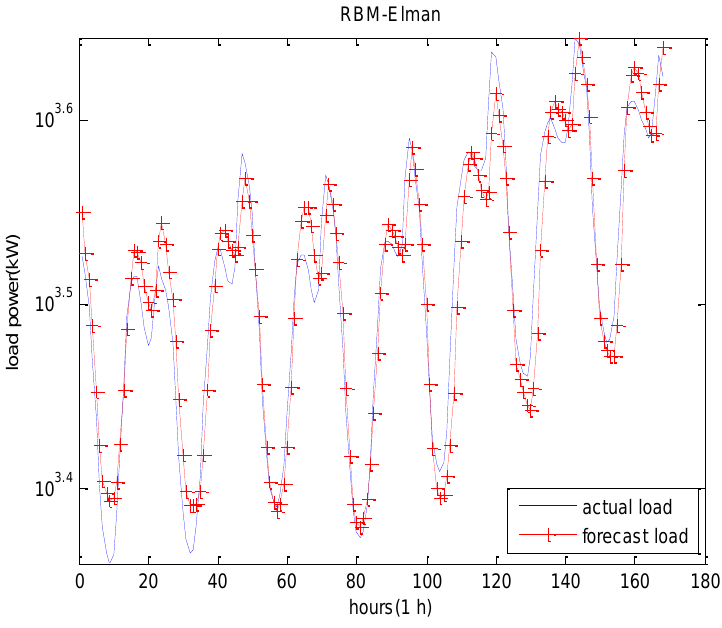
Figure 9. The forecast results of seven consecutive days using RBM-Elman model.